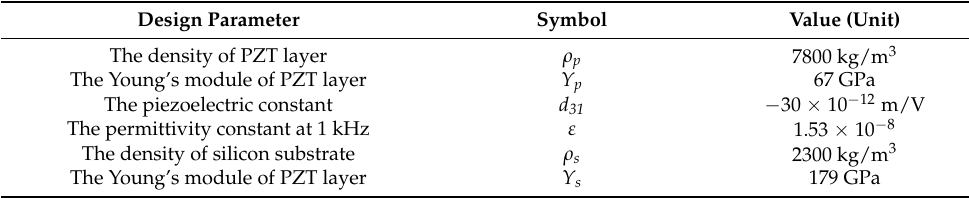
Table 1. The material properties of the PZT layer and the silicon substrate. Design Parameter Symbol Value (Unit) The density of PZT layer ρ p